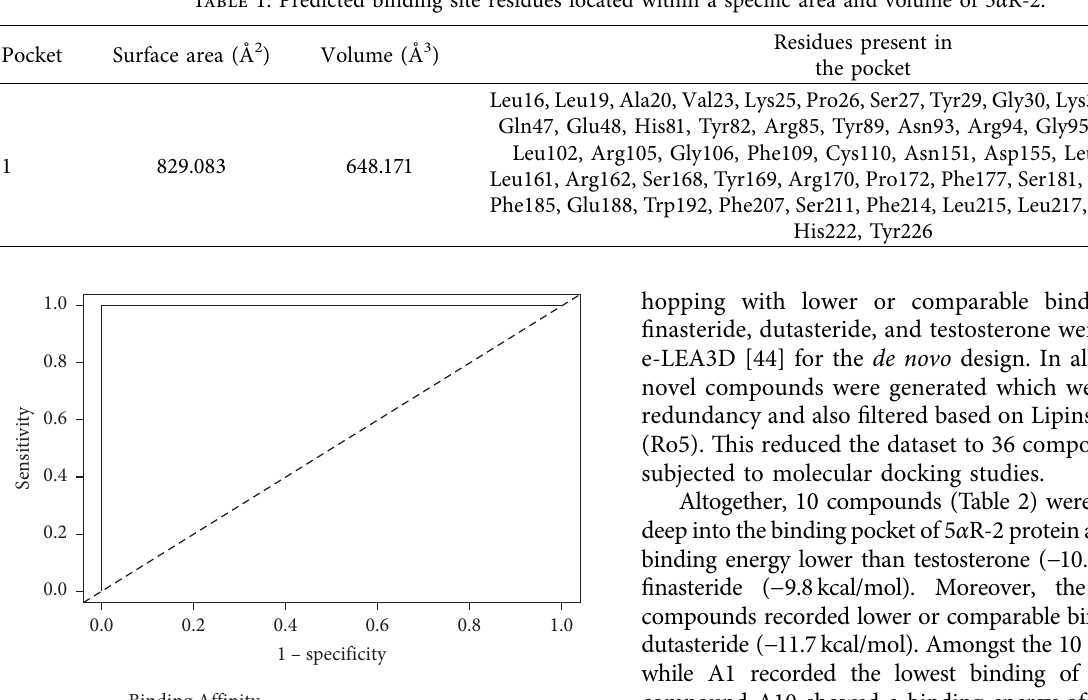
Table 1: Predicted binding site residues located within a specifc area and volume of 5 α R-2.